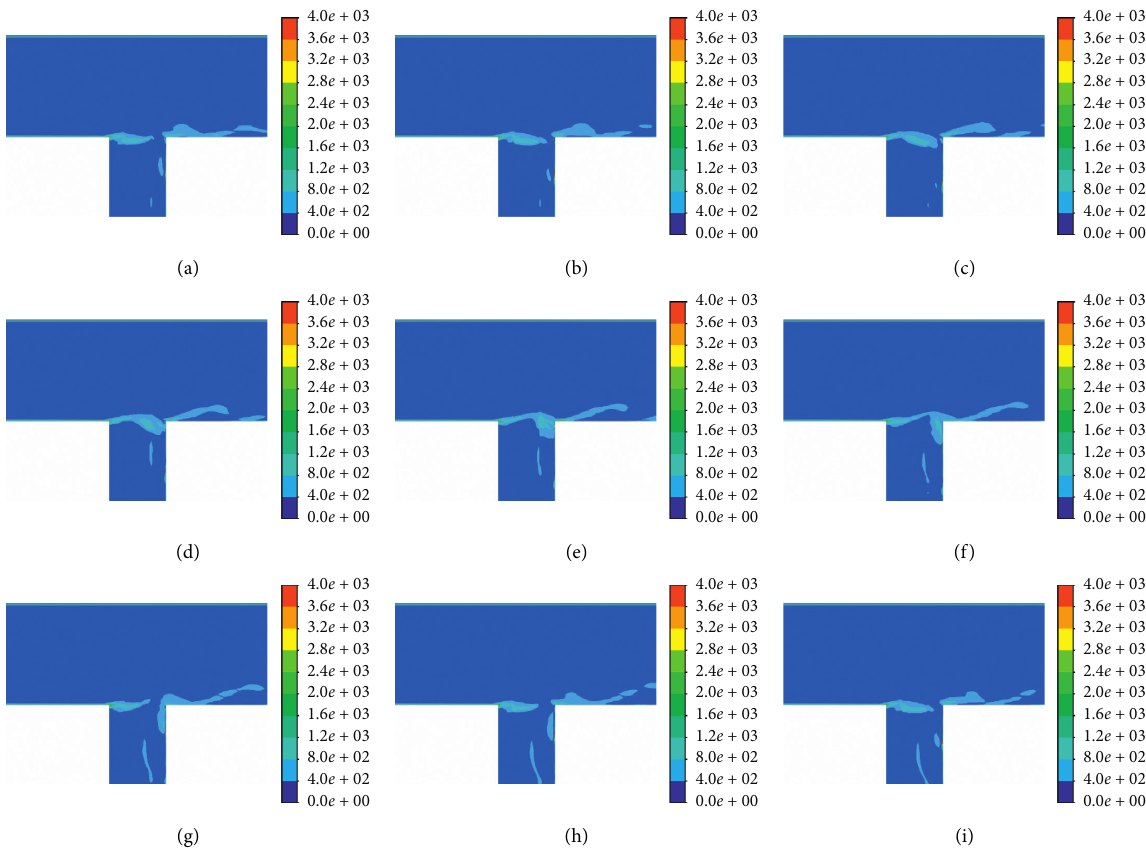
Figure 11: Vorticity ( t 1 � 0.1–0.12s unit: s − 1 ): (a) 0T/8, (b) 1T/8, (c) 2T/8, (d) 3T/8, (e) 4T/8, (f) 5T/8, (g) 6T/8, (h) 7T/8 and (i)